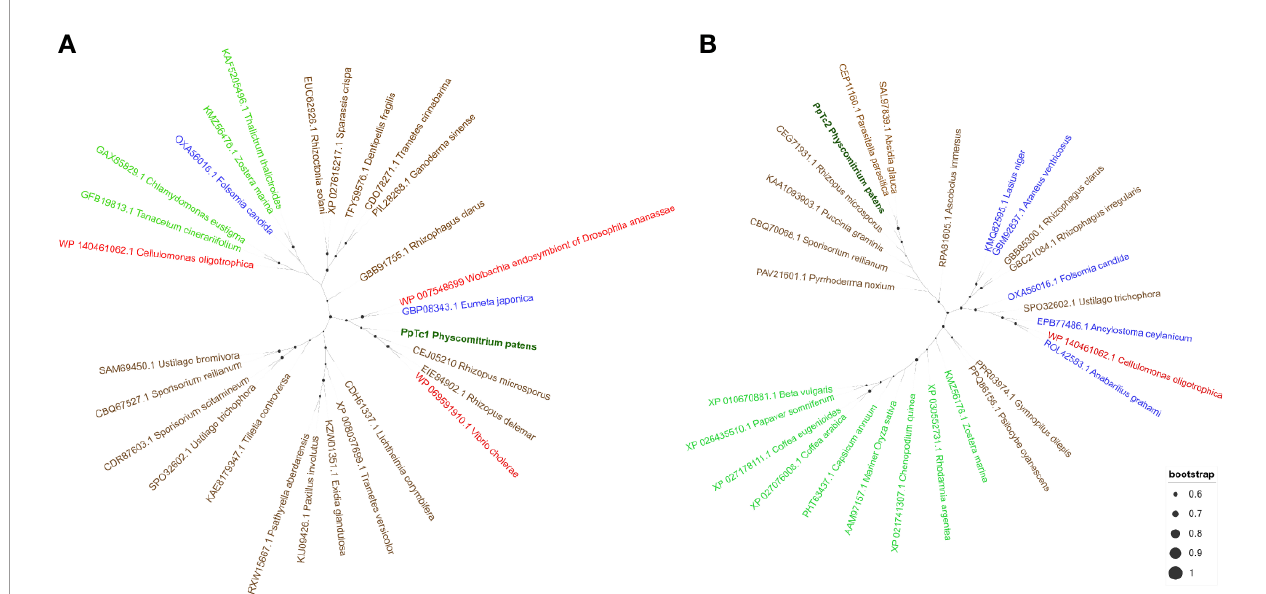
FIGURE 2 | Phylogenetic analysis of the transposases potentially encoded by PpTc1 (A) and PpTc2 (B) with those potentially encoded by plant, fungal, animals and bacterial Mariner-like elements. P. patens sequences are shown in dark green, plant sequences in light green, fungal sequences in brown, animal sequences in blue and bacterial sequences in